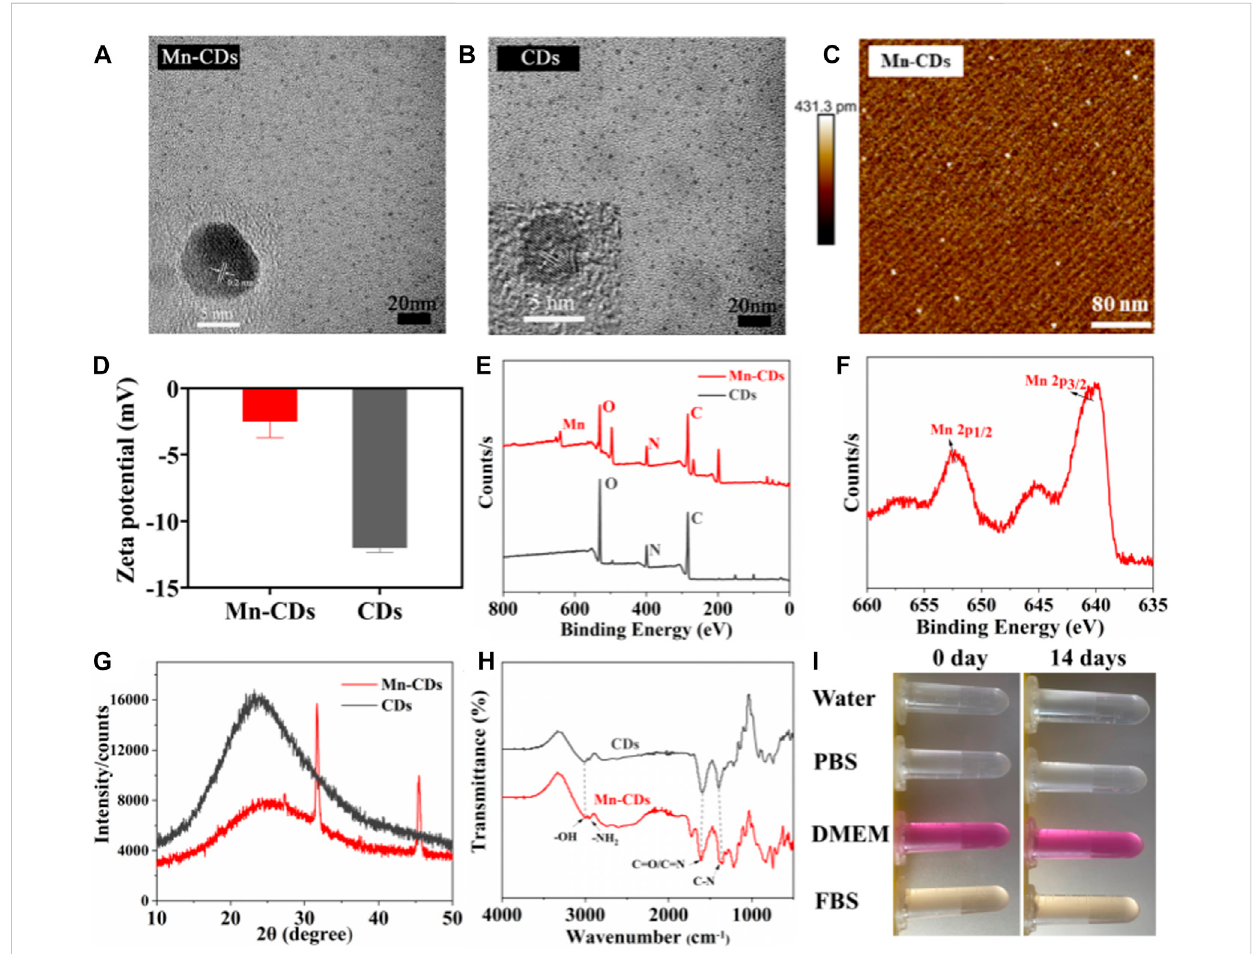
FIGURE 1 Physical andchemicalcharacterization ofMn-CDs and CDs. (A) TEMof Mn-CDs. Inset: HR-TEM of Mn-CDs. (B) TEMof CDs. Inset: HR-TEM ofCDs. (C) AFMofMn-CDs. (D) The ζ potentialsoftheMn-CDsandCDsinaqueoussolution. (E) XPSspectraofMn-CDsandCDs. (F)